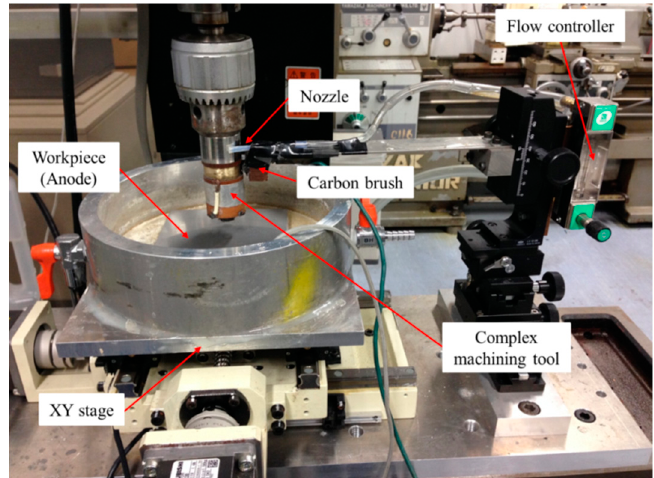
Figure 3. External photo of the experimental setup.